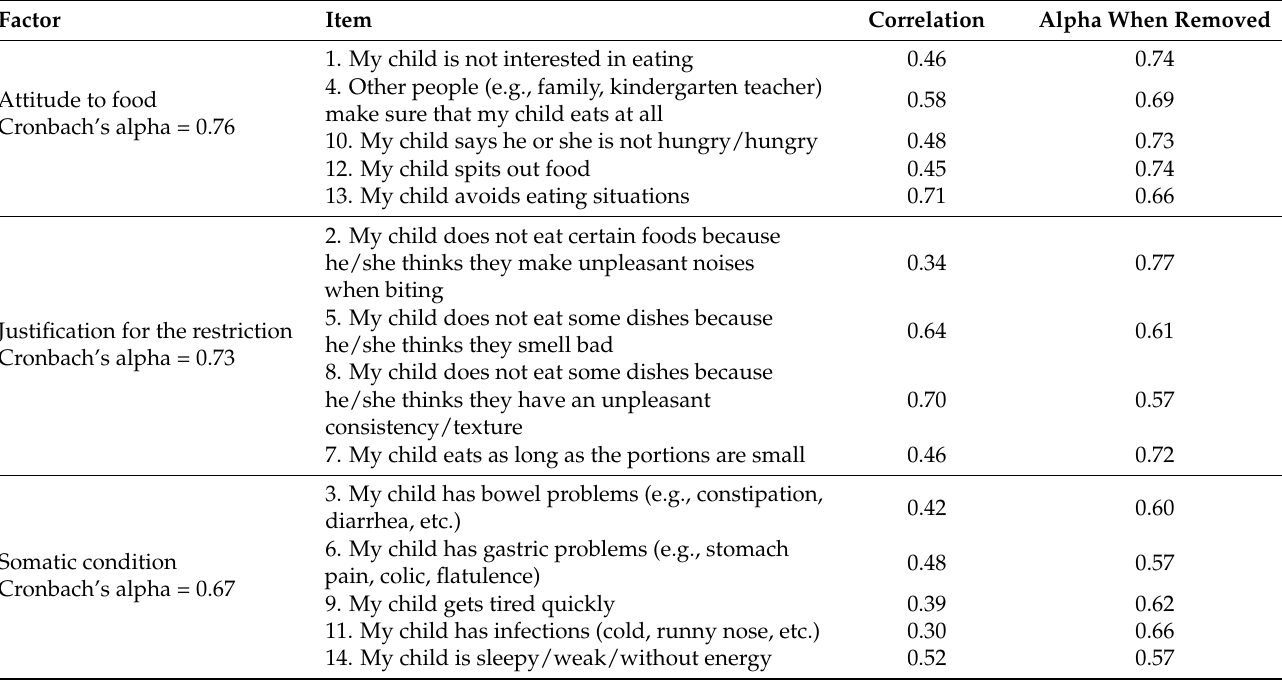
Table 7. Analysis of the reliability of the ARFID-Q-PR (N =